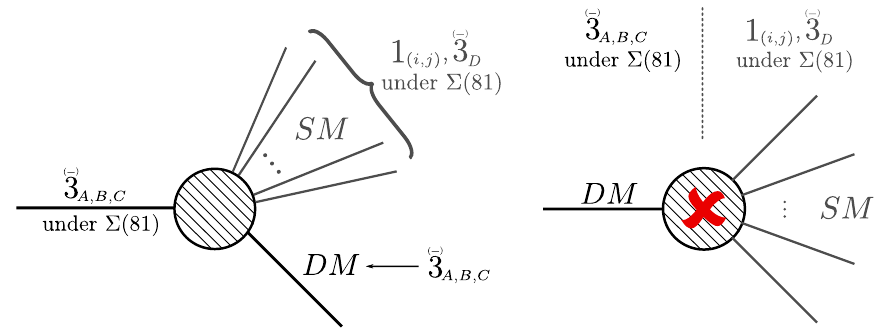
Figure 6 . Stability diagrams of the dark matter sector in the model. The lightest particle charged as 3(¯3) cannot decay into only Standard Model fields. Left: allowed decay channels for a A,B,C dark sector particle will necessarily include at least one dark sector particle in the final state (if kinematically allowed). Right: the lightest dark sector particle cannot decay into Standard Model particles due to the flavour symmetry, thus ensuring its